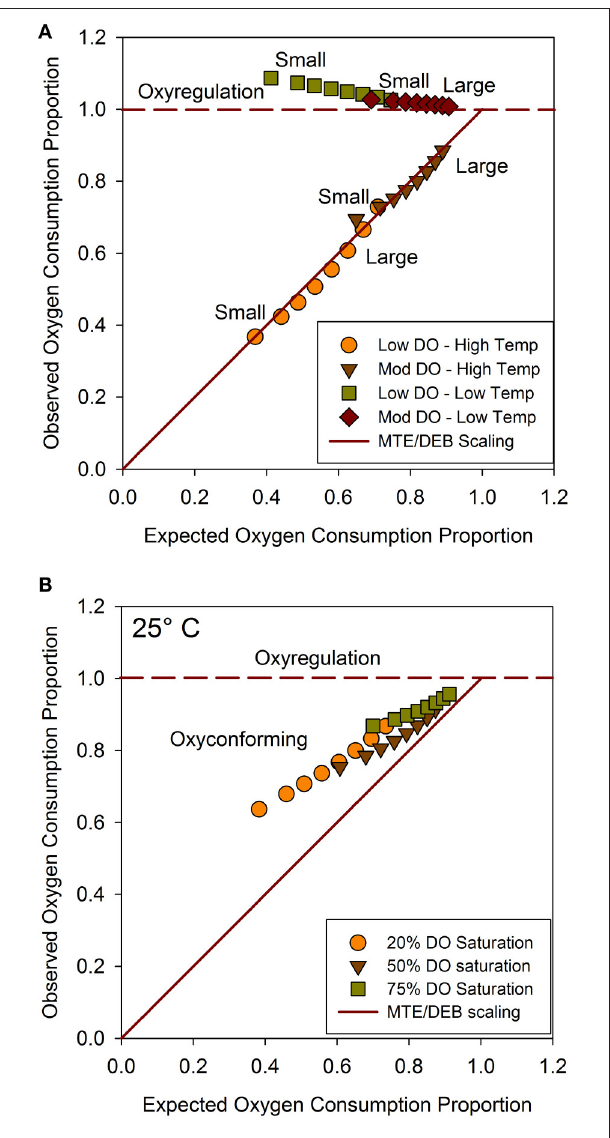
FIGURE 4 | (A) Mean observed (OCR proj ) vs. mean expected (OCR prop ) values for eight size classes, generated from dynamic exposure scenarios; (B) Observed vs. expected OCR values from static combinations of DO saturation at 25 ◦ C. Horizontal reference line depicts oxyregulation and diagonal reference line depicts metabolic scaling hypothesis. Series arrayed from small (left) to large (right) size